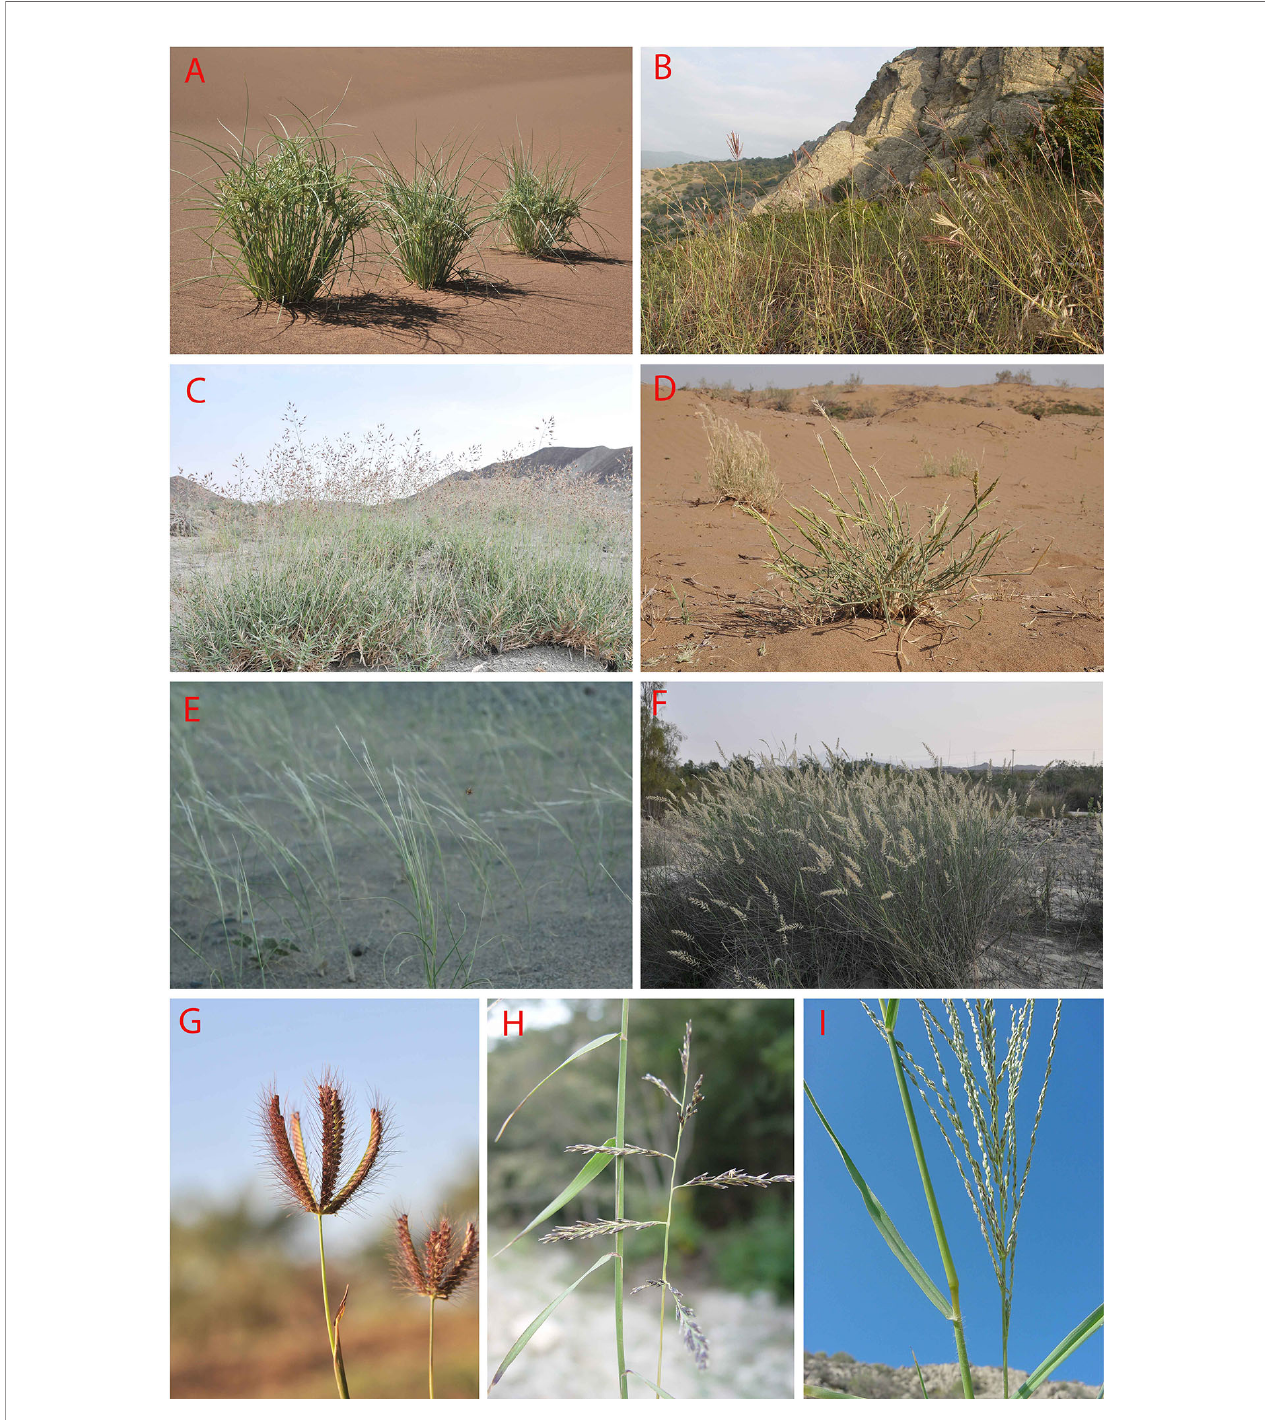
FIGURE 9 | (A – I) : Some representatives of important C 4 Monocot lineages in Southwest (SW) Asia: (A) Cyperus aucheri Jaub. and Spach, sand dune in Desert Lut, Iran; (B) Bothriochloa ischaemum (L.) Keng- B. bladhii (Retz.) S.T. Blake -Cleistogenes serotina (L.) Keng community, S-facing rocky outcrop in Golestan National Park, Iran; (C) Danthoniopsis stocksii (Boiss.) C.E. Hubb., dry river bed, Baluchistan, Iran; (D) Centropodia forskalii (Vahl) Cope, Aran-Bidgol dunes in Esfahan Province, Iran, 6.6.2010; (E) Stipagrostis multinervis H. Scholz, Desert Lut, Iran, 1.4.2011; (F) Cenchrus divisus (J.F. Gmel.) Verloove, 19.2.2013, river side in Bahukalat, Baluchestan, Iran; (G) Chloris barbata Sw., 17.2.2013, ruderal places, in Zehkalut, Kerman, Iran; (H) Cleistogenes serorina (L.) Keng, 13.10.2003, limestone rocky outcrops in Golestan National Park, Iran; (I) Digitaria nodosa Parl., 18.12.2001, rocky shrubland, Kuhe Geno, Hormozgan, Iran (photos by H.